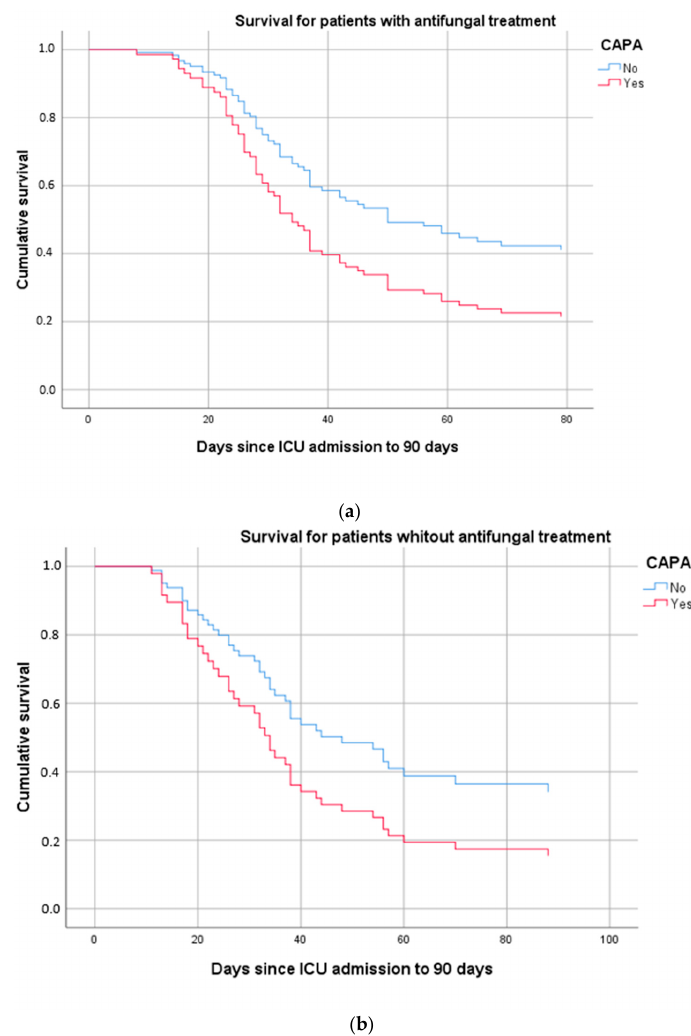
Figure 3. ( a ) Mortality at 90 days from ICU admission in patients with SARS-CoV-2 infection and early antifungal treatment at ICU admission. ( b ) 90-day mortality from ICU admission in patients with SARS-CoV-2 infection without early antifungal treatment at ICU